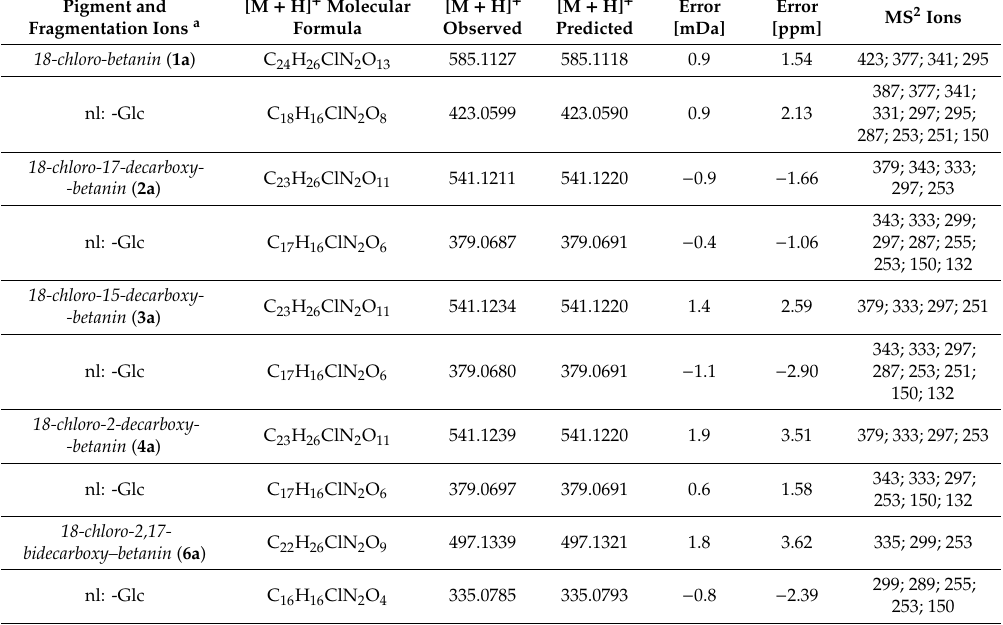
Table 2. High-resolution mass spectrometric data obtained by LCMS-IT-TOF for monochlorinated betanin ( 1a ) and its decarboxylated derivatives ( 2a , 3a , 4a , and 6a ) as well as for their fragmentation ions. Pigment and Fragmentation Ions a